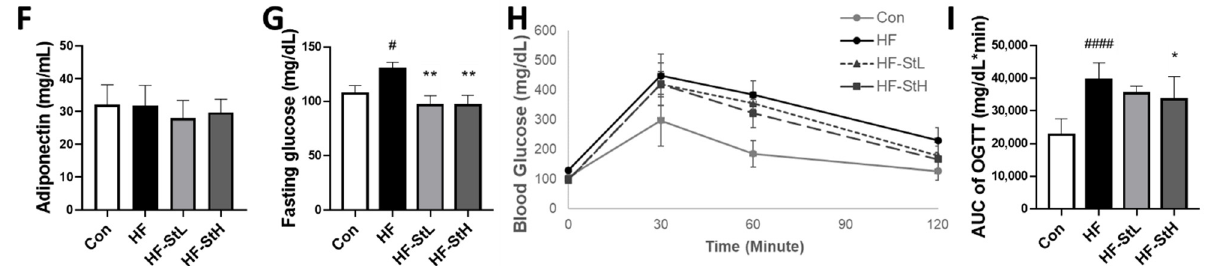
Figure 6. Effects of S. thunbergii (ST) extract on the serum profiles and the glucose levels in high fat-fed C57BL/6 mice. ( A ) Triacylglycerol. ( B ) Total cholesterol. ( C ) HDL-cholesterol. ( D ) LDL-cholesterol. ( E ) Serum leptin. ( F ) Serum adiponectin levels. ( G ) Fasting blood glucose level. ( H ) Curve of OGTT. ( I ) AUC of OGTT. Con: chow diet, HF: high-fat diet, HF-StL: high-fat diet+ST extract 150 mg/kg bw, HF-StH: high-fat diet+ST extract 300 mg/kg bw. All data are presented as means ± SD (n = 10). Compared between the control and the high-fat diet group, # p < 0.05, ## p < 0.01, ### p < 0.001, #### p < 0.0001 by Student's t-test. Compared with the high-fat diet group, * p < 0.05, ** p < 0.01 by one way ANOVA followed by Dunnett’s test.